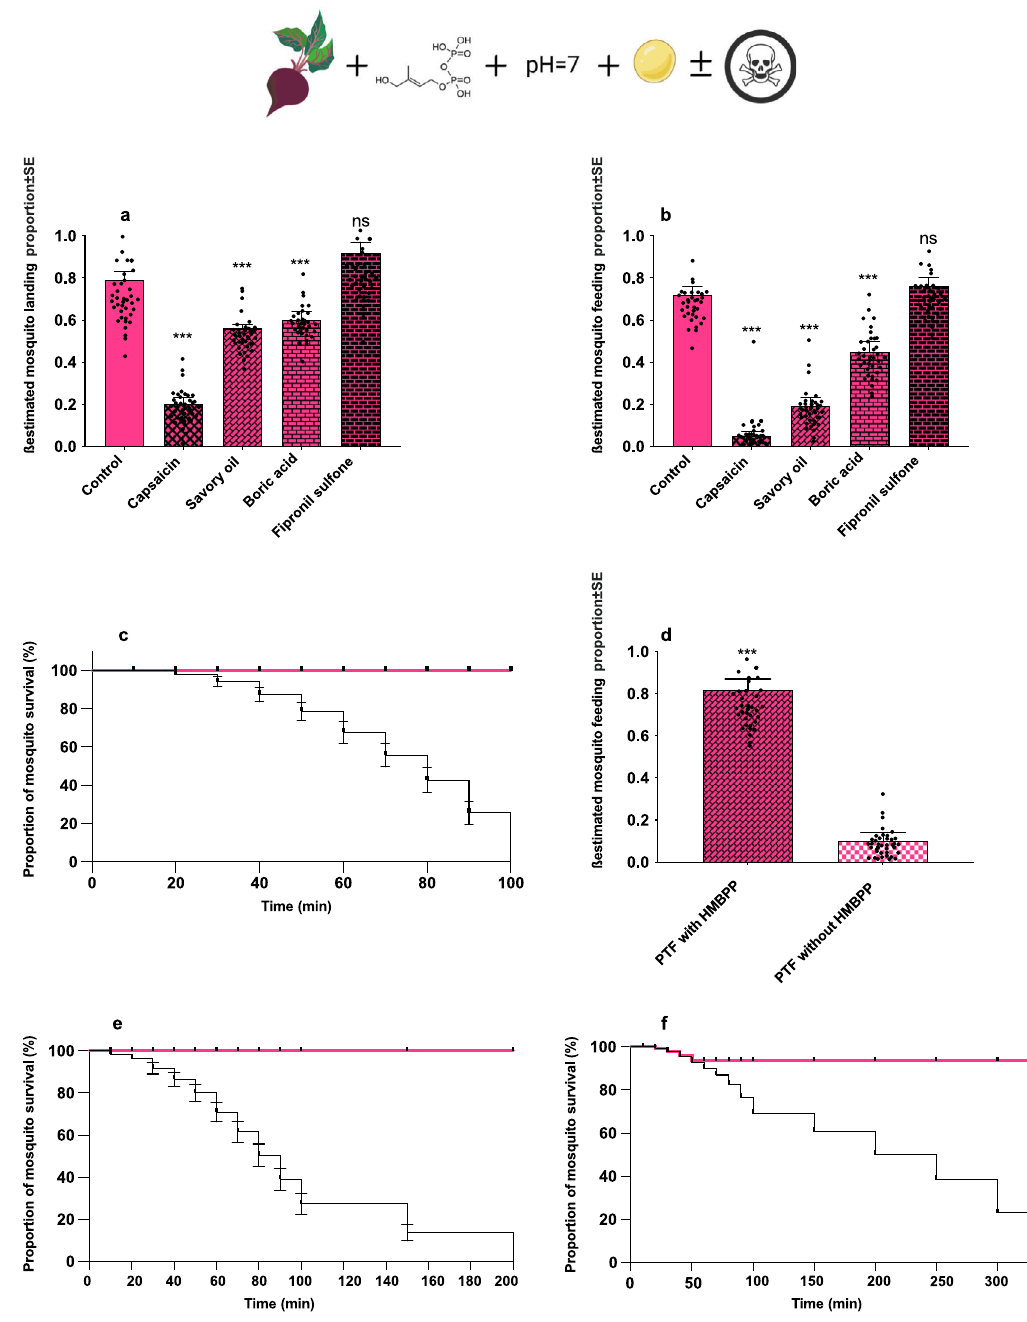
Fig. 4 Supplementation of HMBPP in the optimised non-blood arti fi cial solution with toxins tricks and kills vector. a Proportion of mosquito ( Anopheles gambiae s.l.) landing on toxin-containing solutions compared to the control meal [capsaicin: χ 2 1 = 84.75, p < 0.001; Savory oil: χ 2 1 = 64.70, p < 0.001; boric acid: χ 2 1 = 90.35, p < 0.001; fi pronil sulfone: χ 2 1 = 0.95, p = 0.29]. b Proportion of An. gambiae s.l. mosquito feeding on toxin treatments compared to the control meal. c Kaplan – Meier graph representing the survival of An. gambiae s.l.mosquitoes [%] subsequent to the feeding of fi pronil sulfone (black line) and control (pink) during a 100 min time (time of total death in treatment cohort) frame. d Proportion of mosquitoes ingesting non-blood-feeding solution containing toxin fi pronil sulfone (PTF) with and without the addition of HMBPP ( χ 2 1 = 74.75, p < 0.001). e The survival of Ae.aegypti mosquitoes [%] subsequent to the feeding of fi pronil sulfone (black line) and control (pink) during a 200 min time frame (time of total death in treatment cohort). f The survival of Culex pipiens/Cx. torrentium mosquitoes [%] subsequent to the feeding of fi pronil sulfone (black line) and control (pink) during a 350 min time frame (time of total death in treatment cohort). Bars in panels ( a ), ( b ) and ( d ) are represented by β -estimation generated by the mixed model ± SE ( β -lmer ± SE); asterisks denote signi fi cant differences ( n = 120 in all experiments, * p < 0.05, ** p < 0.01, *** p < 0.001; ns = non-signi fi insects 57 – 59 . However, this type of behaviour remains to be con fi rmed by applying different experimental designs that can prevent insects ’ contact with capsaicin and rule out ‘ burning taste ’ effect which might cause the insect to move out of a treated area.